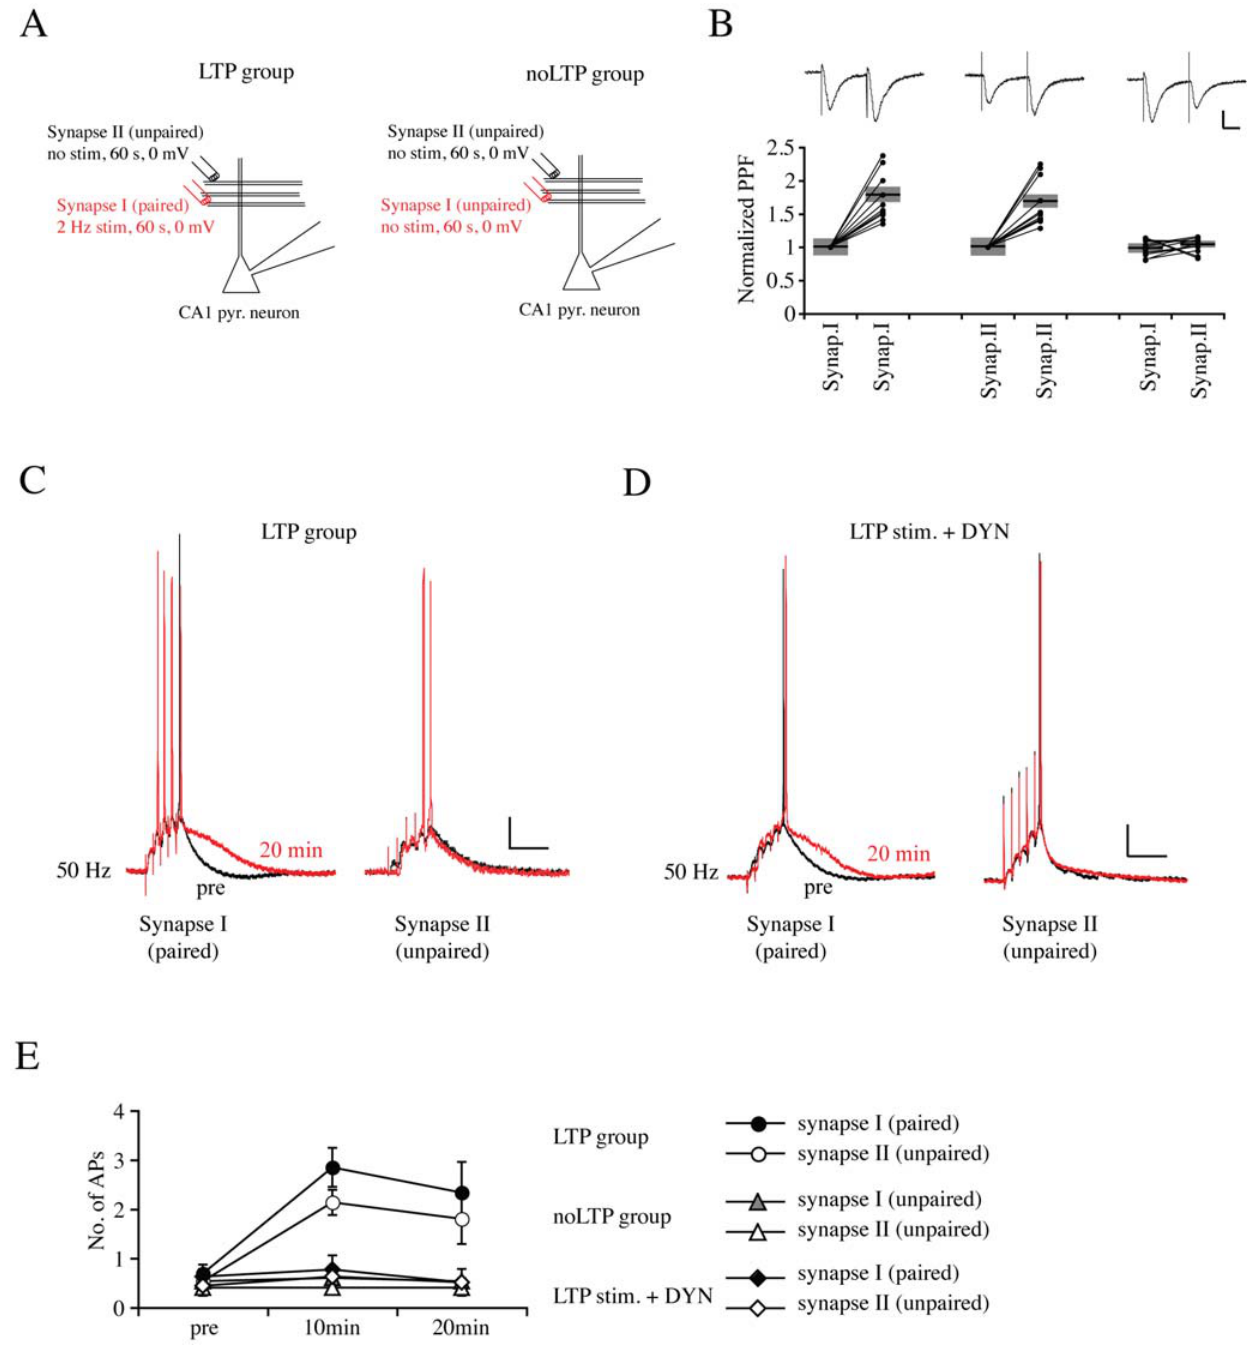
Figure 8. Intrinsic plasticity enhances the throughput of unpotentiated synaptic inputs. A . The experimental protocol used to test the effect of intrinsic plasticity on dendritic signal processing. Two independent synaptic pathways were recorded during each experiment. During conditioning stimulation, a 2 Hz stimulation (for 1 min) was delivered to only one pathway at a 0 mV holding potential (Synapse I (paired) in ‘‘LTP’’ group). For comparison, both sets of synapses did not receive any conditioning stimulation at a 0 mV holding potential for 1 min in some experiments (‘‘noLTP’’ group). The two pathways in all experiments were separated by 50 , 120 m m. All other recording parameters of recording are the same as in Figure 1A. B . A crossed paired-pulse facilitation (PPF) assay was used to confirm pathway independence. Scale bars: 50 pA, 20 ms. Bars indicate the mean value and semitransparent boxes represent SEM. C . Example traces of EPSPs triggered by a train of 5 stimulations at 50 Hz. Before applying conditioning stimulation (black, pre), the stimulation intensity was adjusted to less than threshold. As expected, after conditioning stimulation, EPSP–spike coupling was significantly increased (red traces, 20 min, Synapse I (paired)) in neurons receiving paired stimulation. However, even synapses not exhibiting LTP (Synapse II (unpaired), see also Figure S3C and D) showed increased firing. Scale bars: 10 mV, 100 ms. D. Example traces of EPSPs triggered by a train of 5 stimulations at 50 Hz in the presence of DYN. All recording protocol is as ‘‘C’’, Scale bars: 10 mV, 100 ms. DYN completely blocked the enhanced EPSP-spike coupling in both pared and unpaired pathways. E . AP firing during a 50 Hz stimulation in neurons receiving paired and unpaired stimulation. After LTP induction both sets of synapses in the ‘‘LTP’’ group showed enhanced AP firing, which was blocked by DYN application (LTP + DYN). Error bars represent SEM.